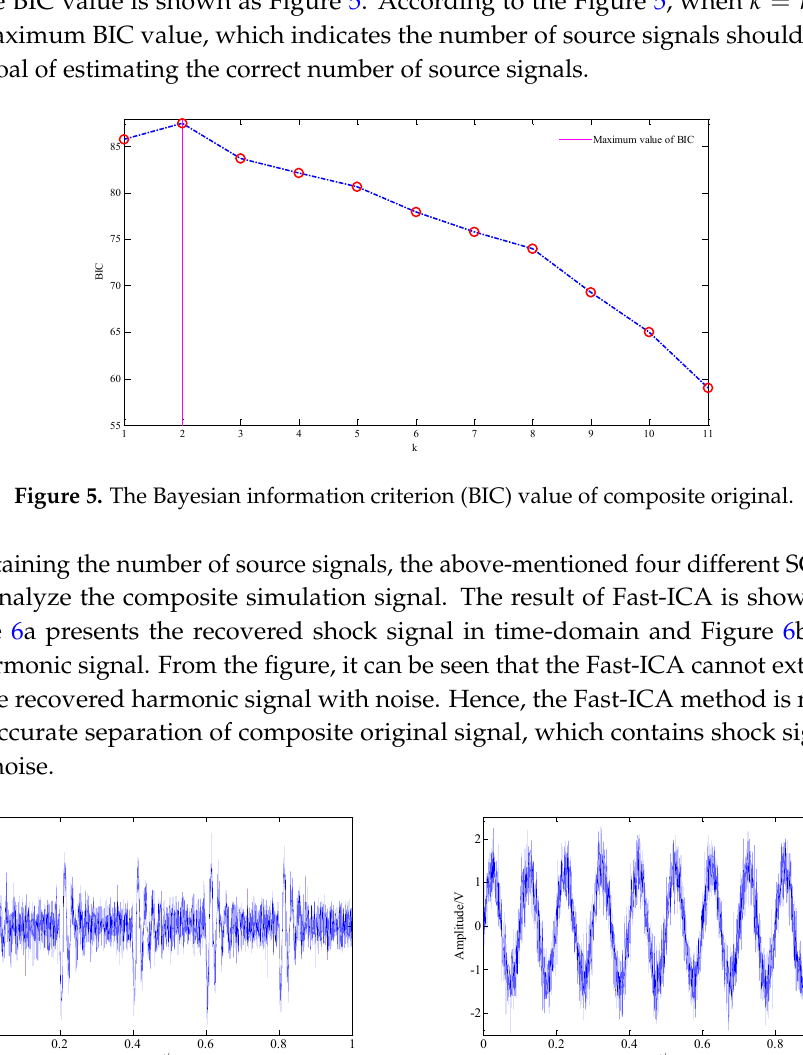
Figure 6. The performance of fast-independent component analysis (ICA): ( a ) recovered shock signal in time-domain; and ( b ) recovered harmonic signal in time-domain.